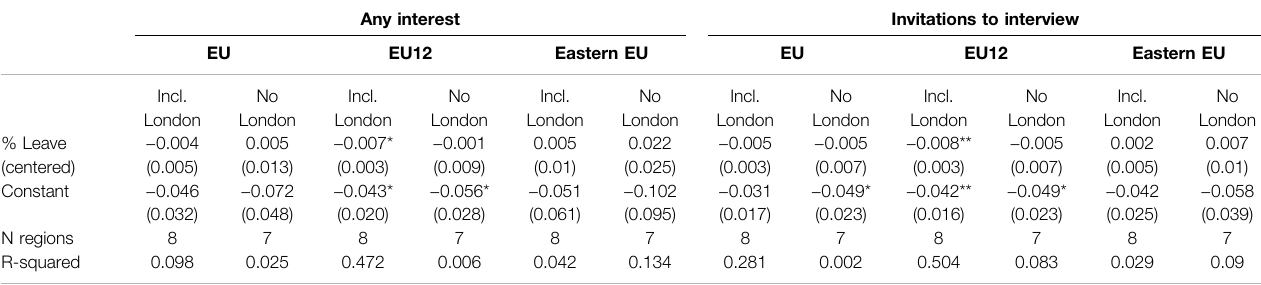
TABLE 6 | Cross-regional variation in the gap in callbacks between white British applicants and those with EU backgrounds: two-step FGLS estimation. Any